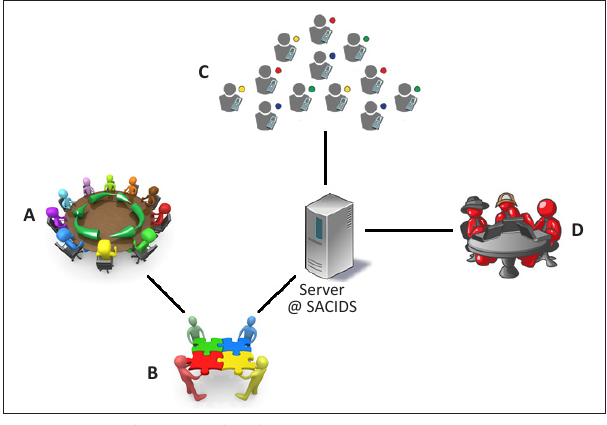
FIGURE 4: The digital forms framework, which moves through, (a) officials (animal and human sectors) designing a hard copy form, (b) digitising forms and uploading onto phones and the server, (c) users downloading forms, collecting and synchronising data to the server and (d) viewing and analysing surveillance data through the web interface.